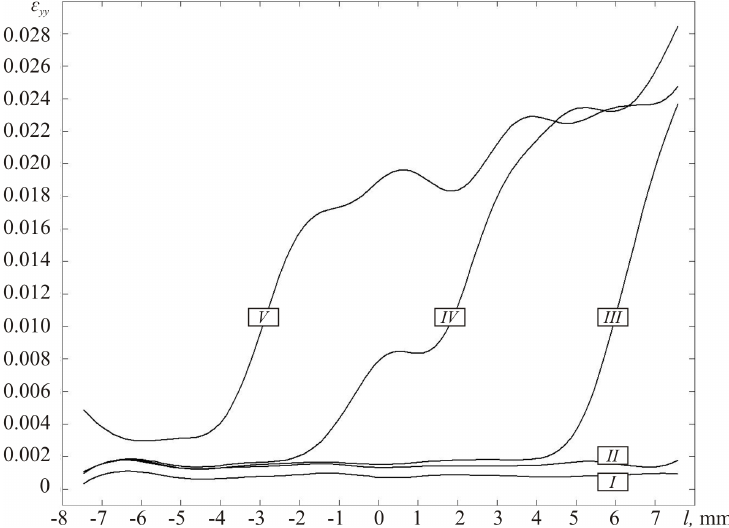
Figure 5: Axial strain distributions at the elasto-plastic deformation